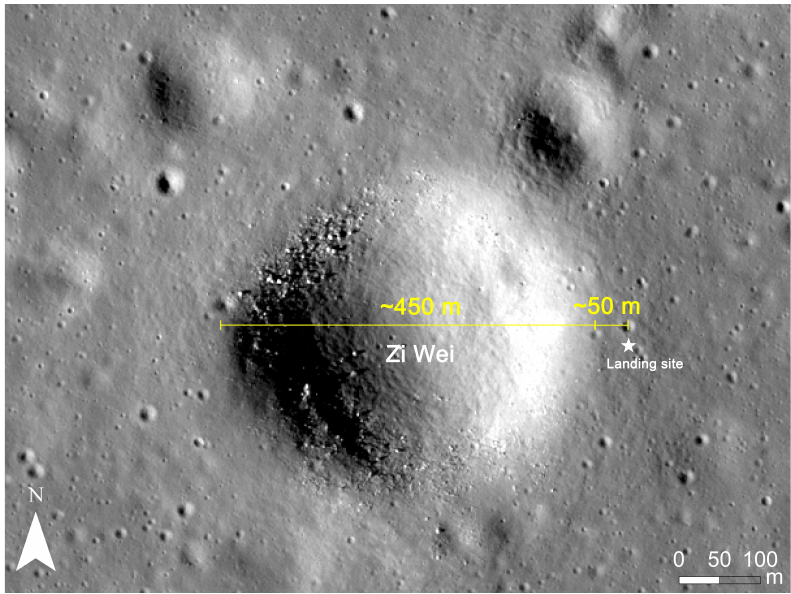
Figure 1. Yutu landed on the eastern rim of the Zi Wei crater. The landing site of Chang’E-3 mission is marked by a white star. The base image is from the Lunar Reconnaissance Orbiter Camera Narrow Angle Camera (LROC NAC; NAC image ID: